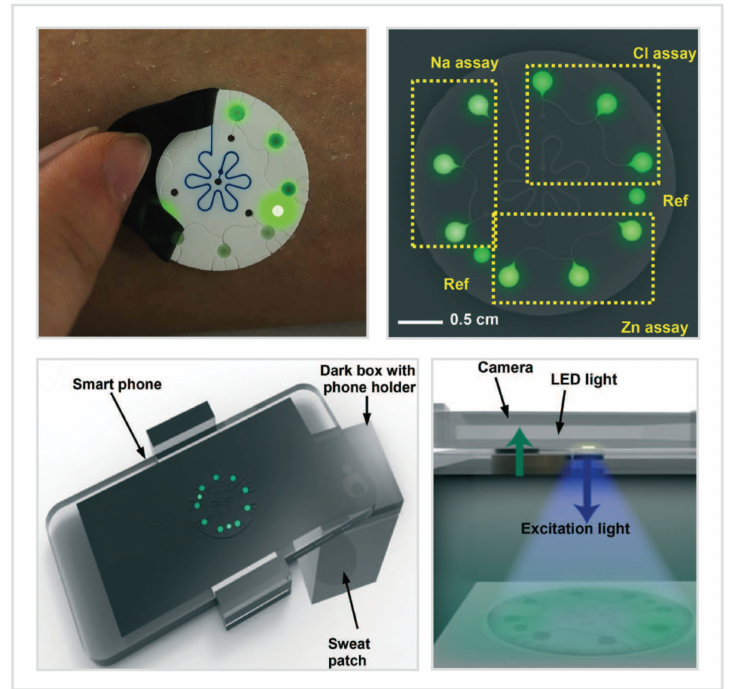
Figure 5. A fluorometric microfluidic biosensor for the detection of sweat biomarkers. Digital image of a fluorescent-based microfluidic device for in situ sensing the concentrations of sweat chloride, sodium, and zinc; fluorescent image illustrating the signals associated with targeted biomarkers; schematic illustrations of the smartphone-based optical module for fluorometric sensing